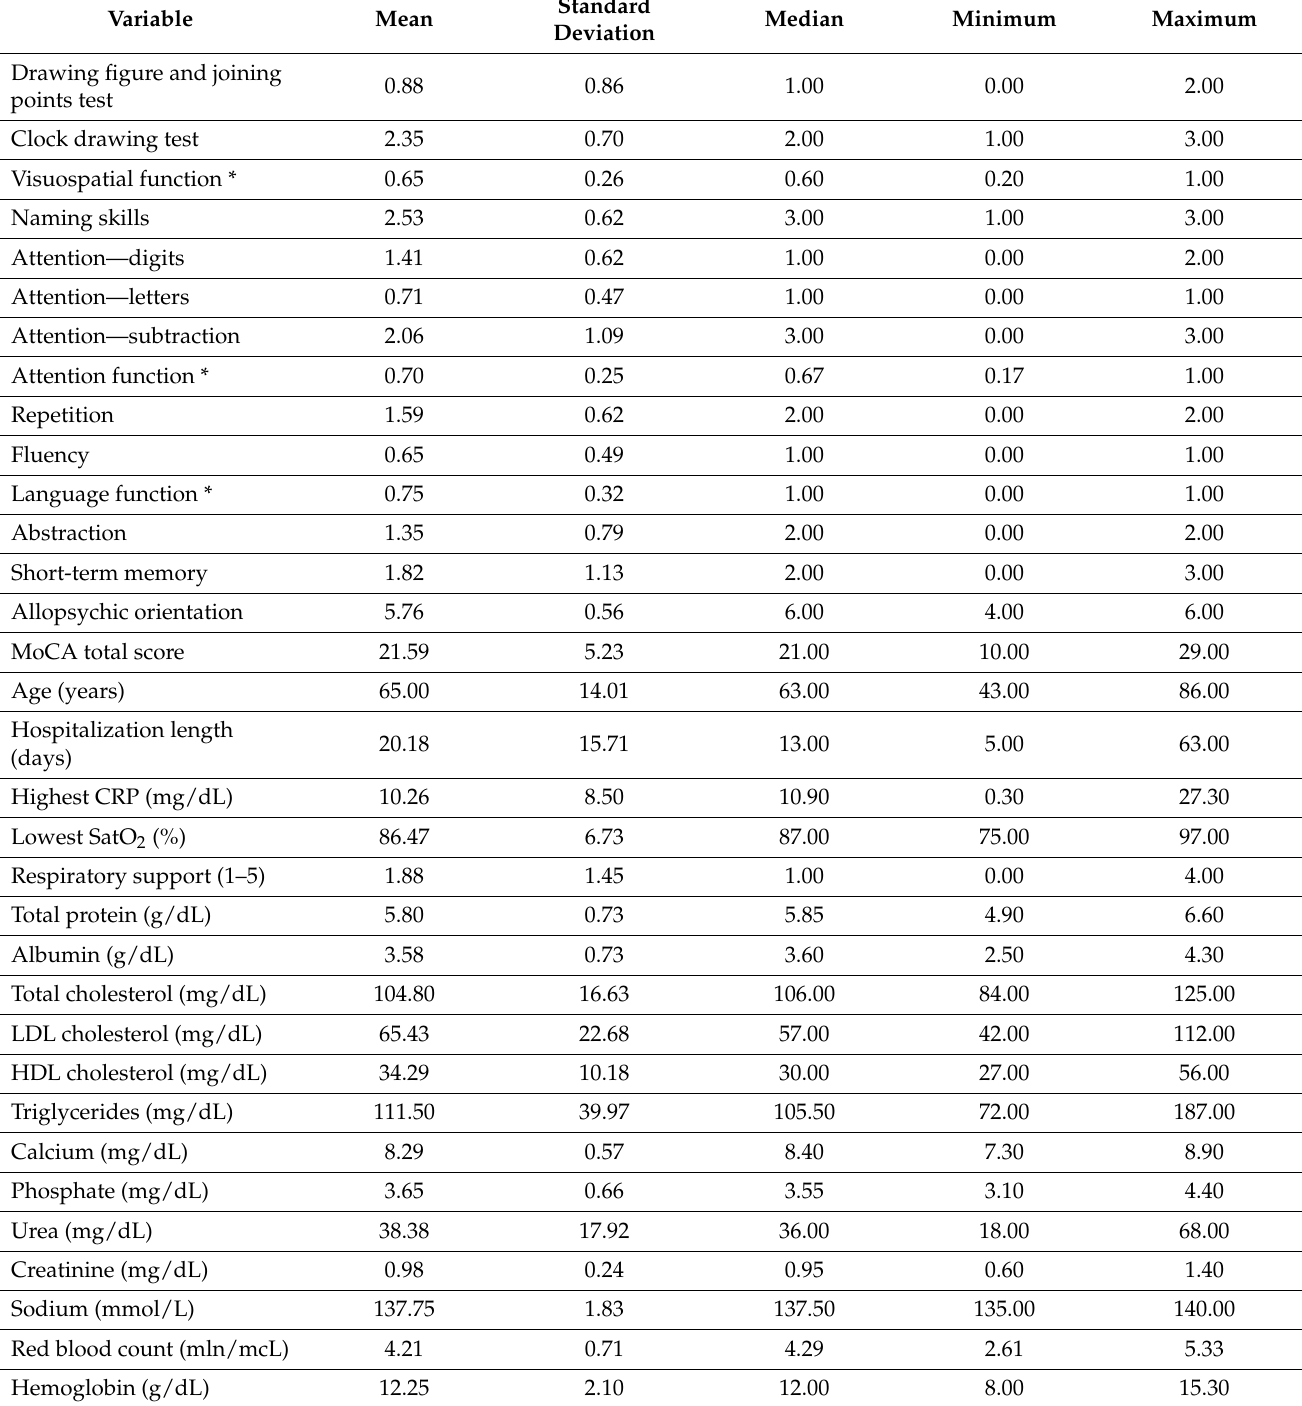
Table 1. Results of the categories assessed with MoCA, disease severity and nutrition